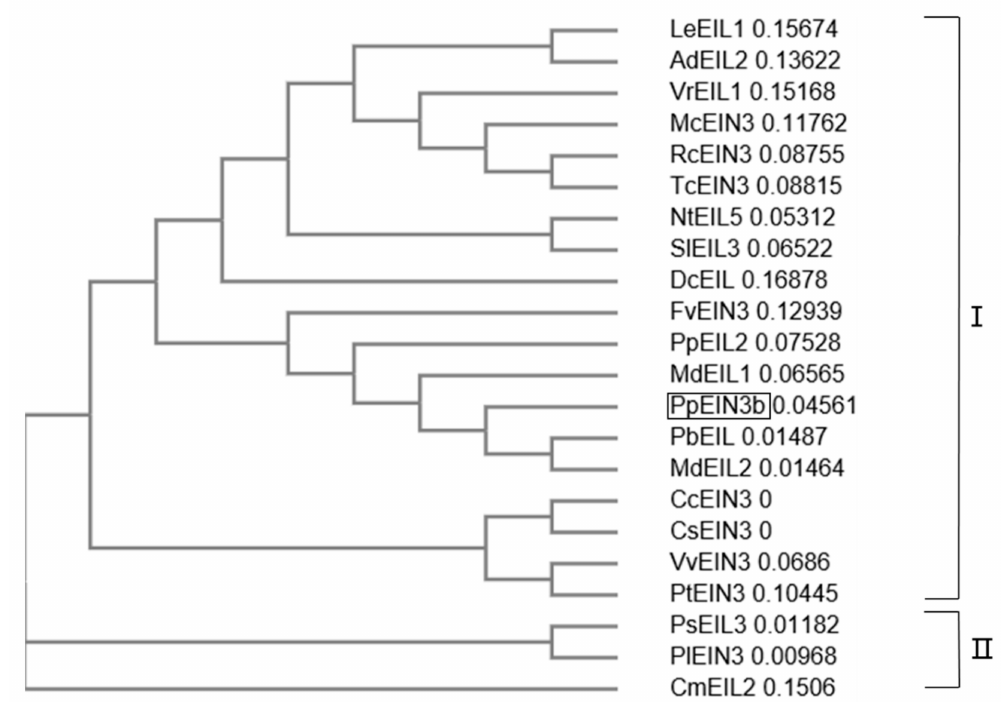
Figure 2. Phylogenetic relationships of PpEIN3b with other EIN3s / EILs. The neighbor-joining evolution tree was constructed in Clustal Omega and divided into two clades, I and II. GenBank accession numbers of plant EIN3s / EILs are: PpEIN3b ( Pyrus pyrifolia , KT726839), LeEIL1 (FJ890314, Lithospermum erythrorhizon ), AdEIL2 (EU887511, Actinidia deliciosa ), VrEIL1 (AF467784, Vigna radiate ), McEIN3